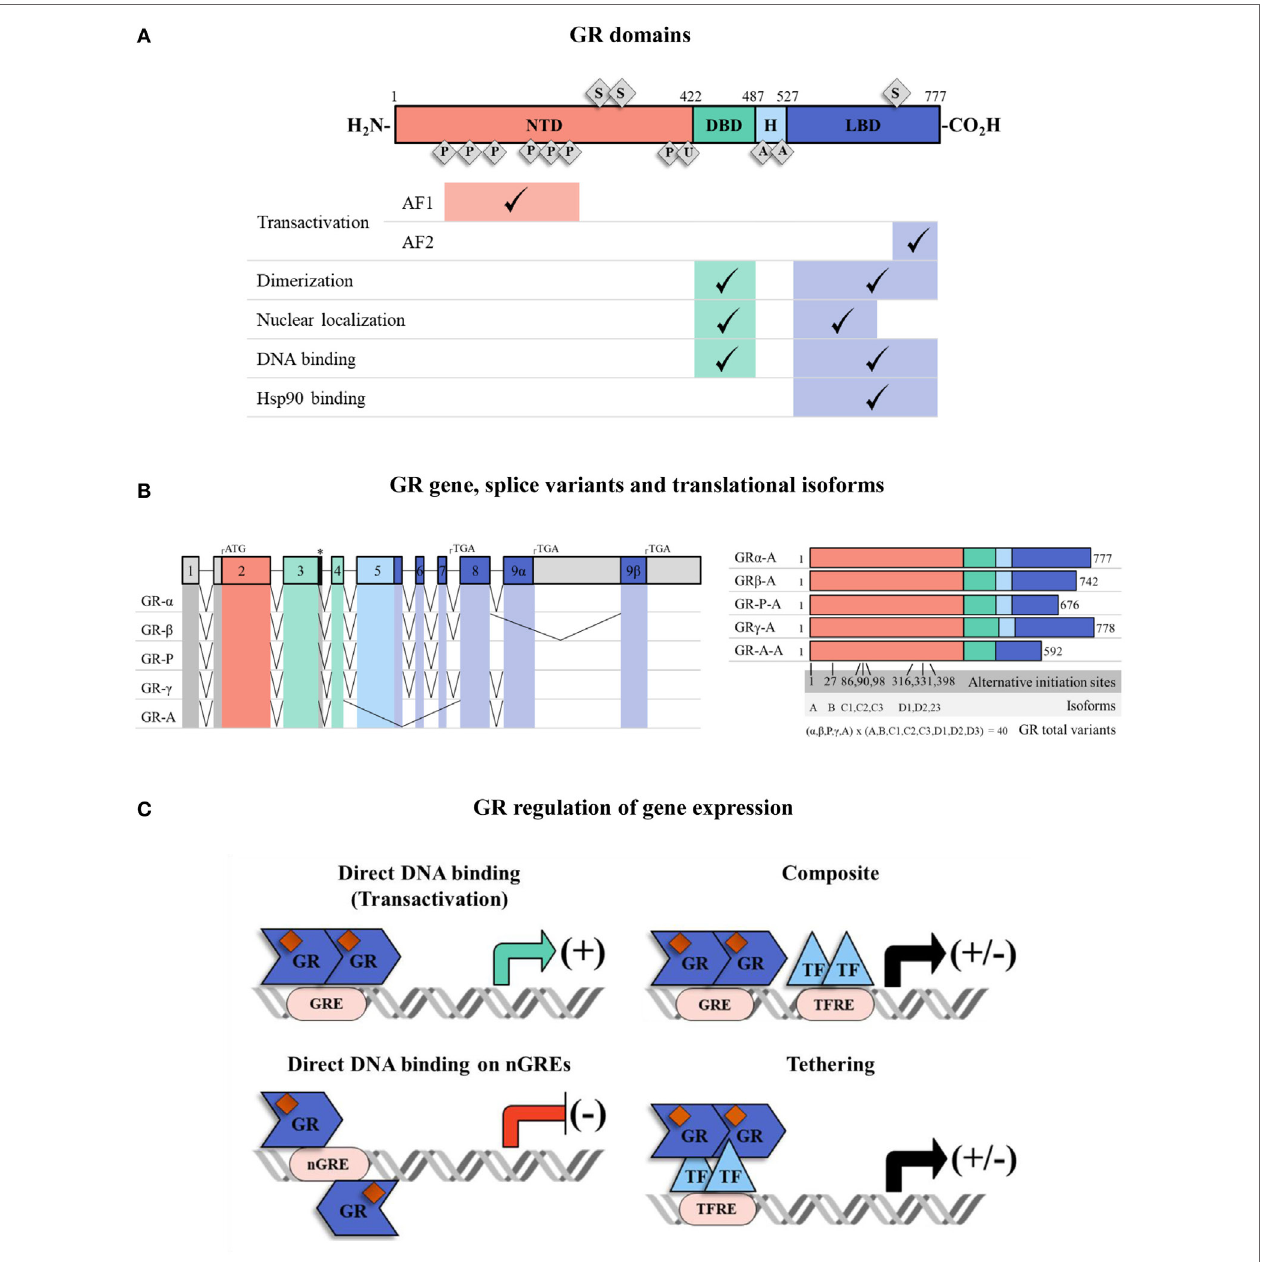
FiGURe 1 | The glucocorticoid receptor (GR) structure, isoforms, and mechanisms of transcriptional regulation. (A) Full human GR α protein has an N-terminal domain (NTD), a DNA-binding domain (DBD), a ligand binding domain (LBD) and a hinge region (H) between DBD and LBD. They have different associated functions, e.g., transactivation, dimerization, nuclear localization, DNA binding, and heat-shock protein 90 binding. The receptor can be post-translationally modified by phosphorylation (P), ubiquitination (U), acetylation (A) and sumoylation (S). Regions associated with transactivation (activation function 1 and 2: AF1 and AF2) are shown. (B) The GR has various isoforms which result from alternative splicing and multiple transcriptional start sites at exon 2. The colors indicate NTD (red, exon 2), DBD (green, exons 3–4), H (light blue, exon 5) and LBD (dark blue, exon 5–9). The 5 ′ and 3 ′ -untranslated regions are colored in gray. There are five patterns of alternative splicing that result in GR isoforms α , β , P, γ , A. Each of them has eight translational variants (A, B, C1, C2, C3, D1, D2, D3) depending on the transcriptional start site (“*” denotes an alternative splice donor site in the intron between exons 3 and 4). (C) The GR, carrying GC ligand, translocates to the nucleus and regulates gene expression. GR can directly activate/inactivate gene expression by interacting with GREs/nGREs, it can bind to GREs and modulate gene transcription by interacting with neighboring DNA-bound transcription factors (TFs) (composite mechanism) and it can act by attaching itself to DNA-bound TFs (tethering mechanism). Abbreviations: TF, transcription factor; GRE, glucocorticoid response element; nGRE, negative glucocorticoid response element; TFRE, transcription factor response element.